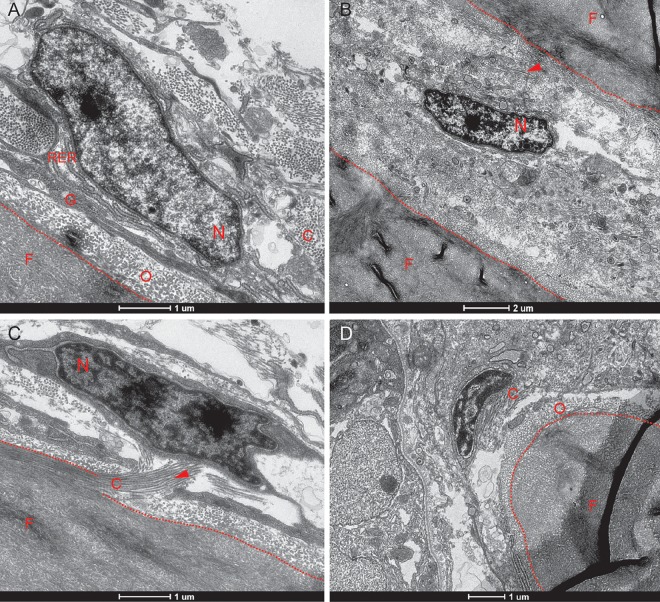
Transmission electron micrographs show various osteogenic cells within the interfrontal sutures.The calvarium was isolated from adult zebrafish at 14 wpf. (A) An osteoblast in direct contact with the osteoid of the upper frontal plate, indicative of ongoing ossification. (B) A mid-suture osteoblast not attached to bone. (C) The longitudinal organization of collagen fibrils along the frontal bone. (D) The tip of the lower plate of the frontal bone, with adjacent associated osteoblast. Abbreviations: C—collagen fibrils, F—frontal bone, G—Golgi apparatus, N—nucleus, O–osteoid, RER–rough endoplasmic reticulum; arrows indicate collagen fibrils.